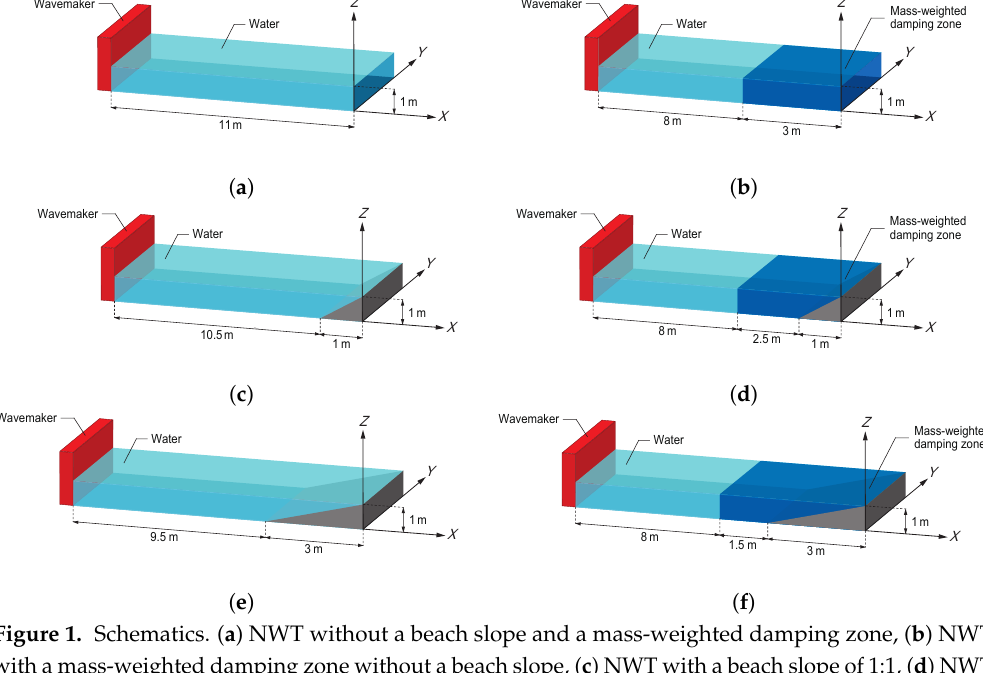
Figure 1. Schematics. ( a ) NWT without a beach slope and a mass-weighted damping zone, ( b ) NWT with a mass-weighted damping zone without a beach slope, ( c ) NWT with a beach slope of 1:1, ( d ) NWT with a beach slope of 1:1 and a mass-weighted damping zone, ( e ) NWT with a beach slope of 1:3, and ( f ) NWT with a beach slope of 1:3 and a mass-weighted damping zone.